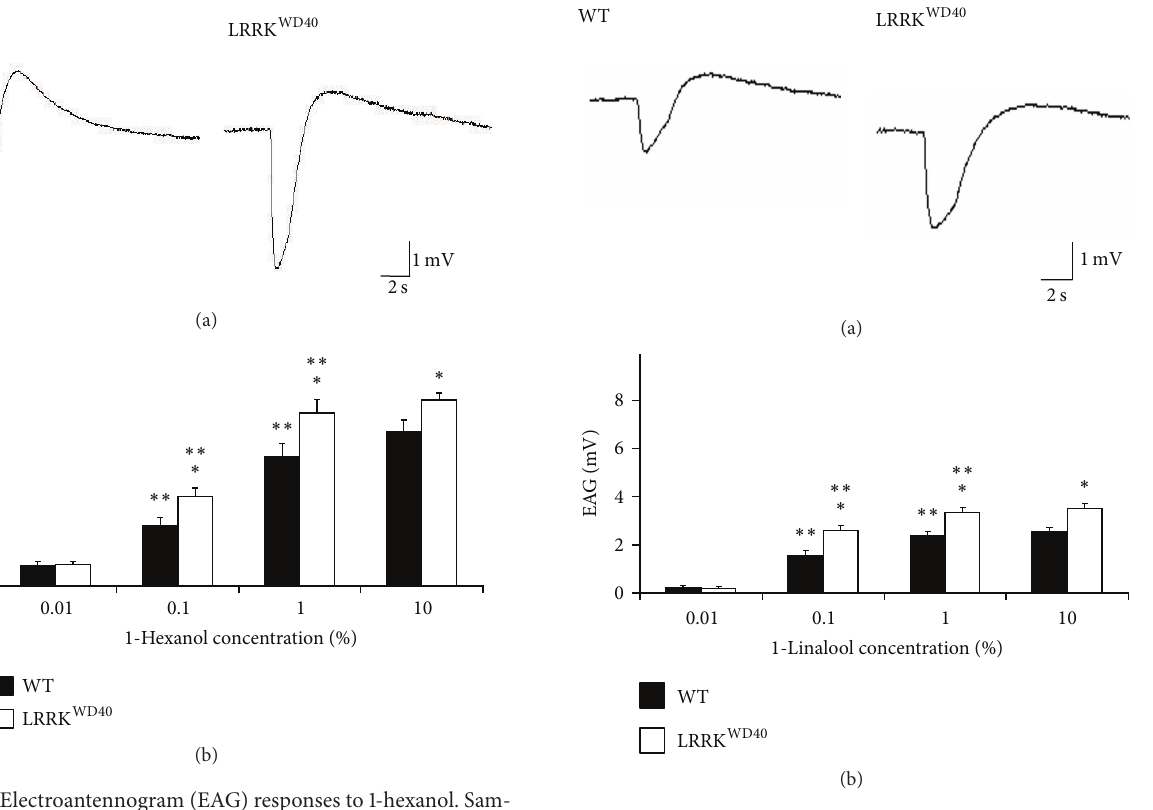
Figure 2: Electroantennogram (EAG) responses to 1-linalool. Sam- ple EAG recordings (a) and EAG amplitude values (b) elicited by stimulation with the different concentrations of 1-linalool (0.01, 0.1, 1, and 10%v/v) in male antennae of WT and LRRK WD 40 mutant flies. Mean values + SEM from 24–26 antennae for each stimulus concentration and insect sample. ∗ and ∗∗ indicate significant differences ( 𝑃 < 0.05 ; HSD post hoc test subsequent to one- way ANOVA or repeated-measures ANOVA) from WT and from preceding concentration of same stimulus,